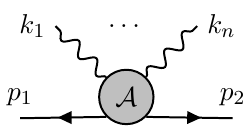
Figure 1. Off-shell current. The blob represents a sum over tree-level Feynman diagrams. Wavy lines represent off-shell outgoing massless gauge